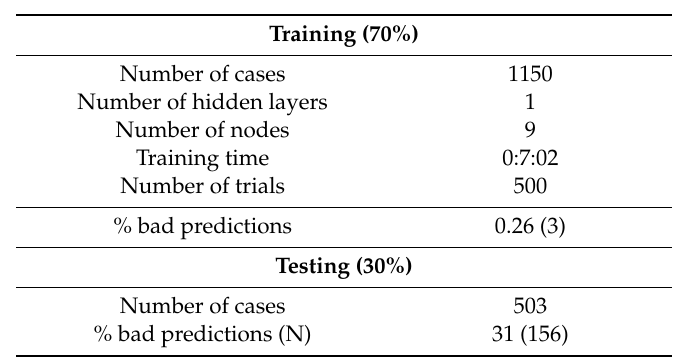
Table 4. Characteristics and principal results of the Multi-Layer Feed forward artificial neural Network (MLFN) model (training and internal test) in predicting the coral activity status (i.e., bloated vs. non-bloated) for the training and the test sets.